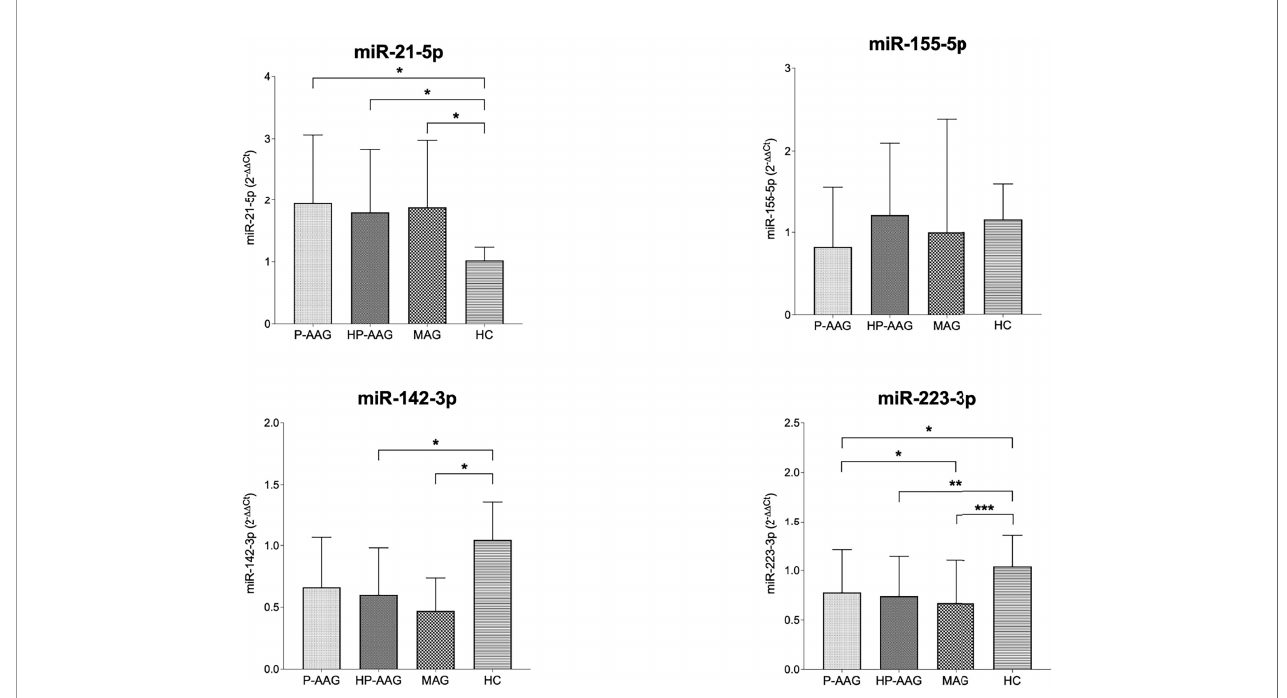
FIGURE 1 | miRNA expression in our study population. *p < 0.05 and ≥ 0.01. **p < 0.01 and ≥ 0.001. ***p <